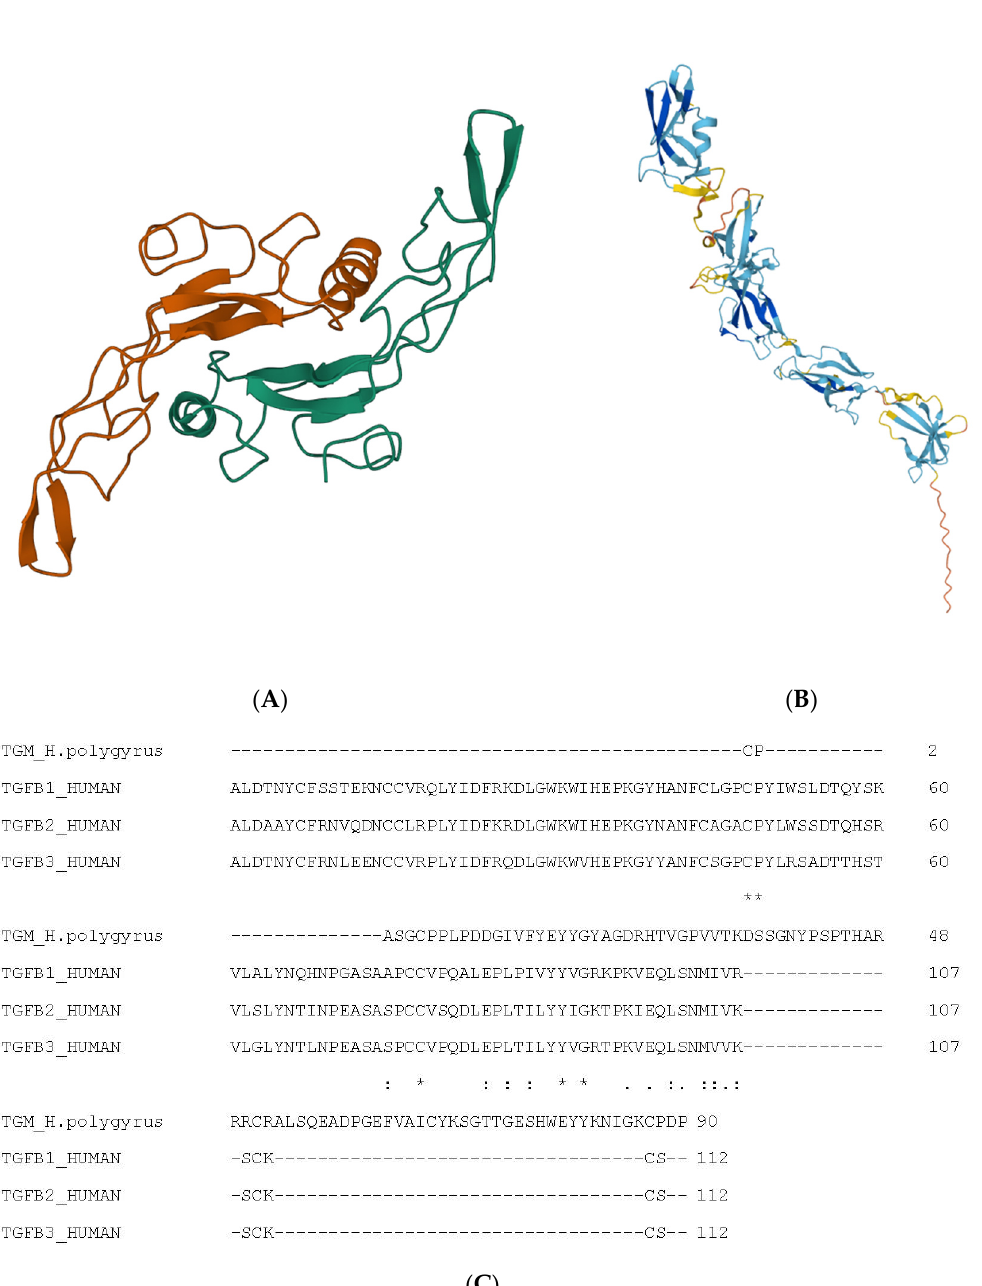
Figure 1. Structure of TGF β 1 and nematode-derived mimic TGFM. ( A ) Structure of TGF β 1. ( A ) Used Mol* to create visualisation [8]. Alpha helices are indicated as coils, whereas beta-pleated strands are indicated as arrows. ( B ) Structure of TGFM. ( B ) Also used Mol* for visualisation. Alpha helices are indicated as coils, whereas beta-pleated strands are indicated as arrows. ( C ) Multiple sequence alignment of TGF β isoforms and nematode-derived mimic TGFM. The ‘*’ indicates an identical amino acid while the ‘:’ indicates a similar amino acid.